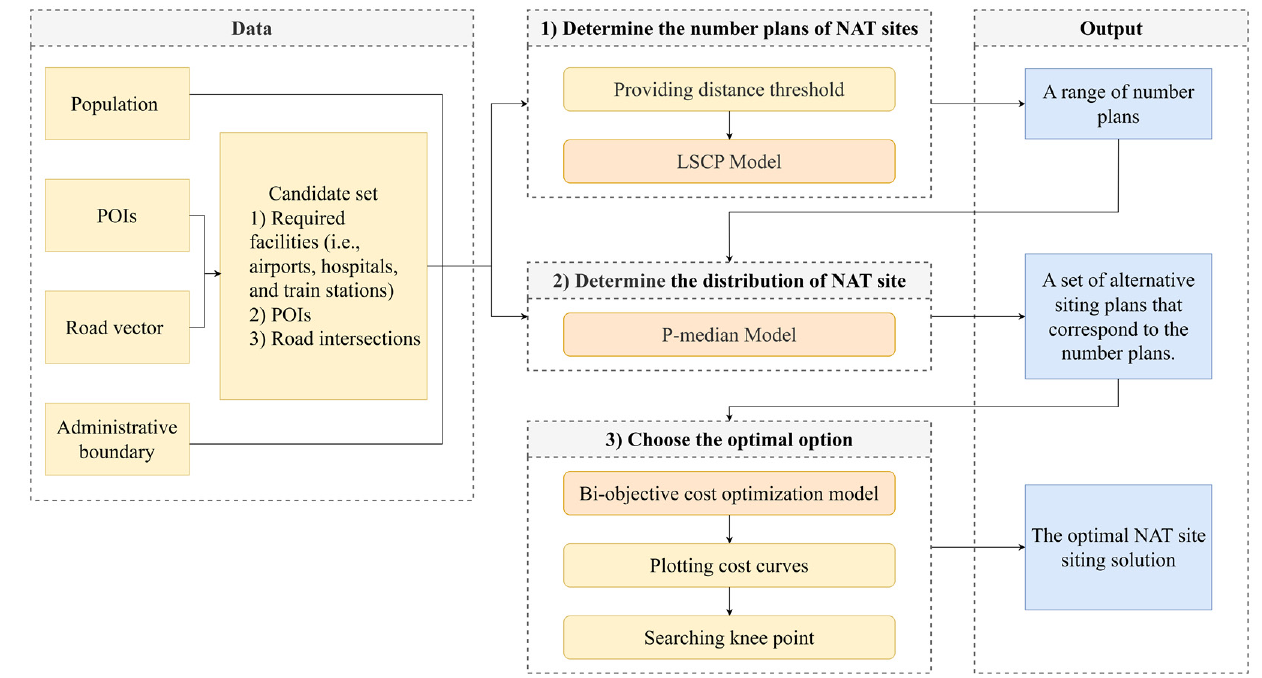
Figure 3. Work fl ow of the proposed method. Figure 3. Workflow of the proposed